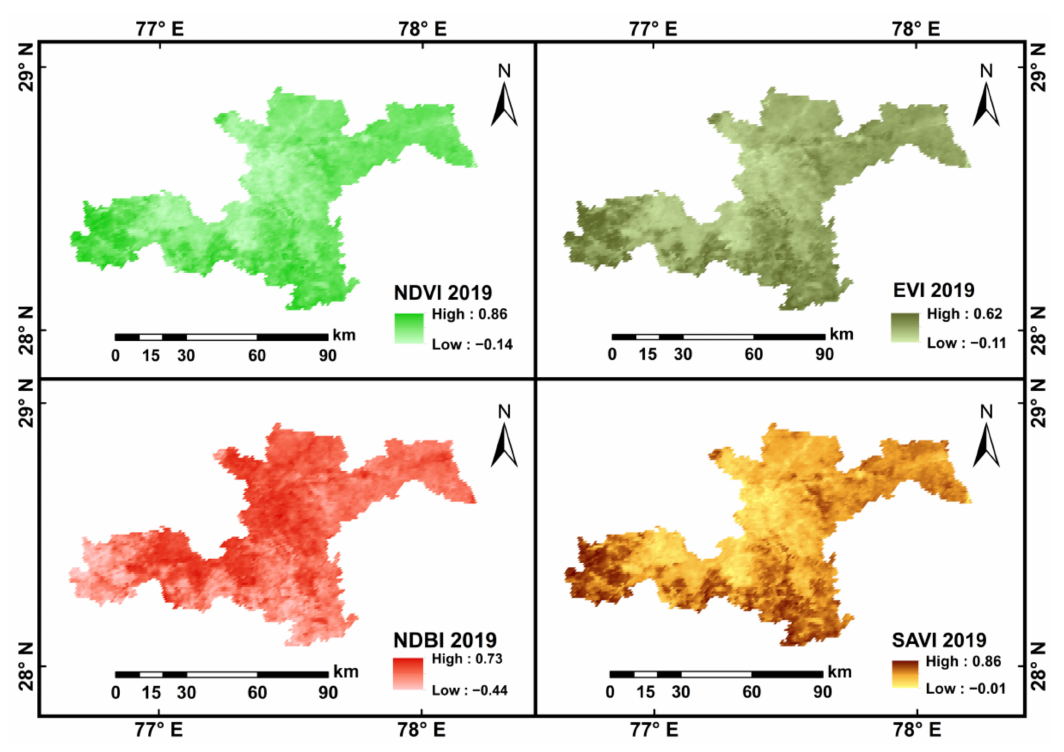
Figure 8. Maps of NDVI, NDBI, EVI and SAVI of Terra MODIS 2019. More vegetation is usually indicated by higher and positive NDVI, EVI, and SAVI values. Negative and lower vegetation indices are associated with urban and rural develop- ment. The city area of Faridabad, Gurugram, Ghaziabad, and Gautam Buddha Nagar